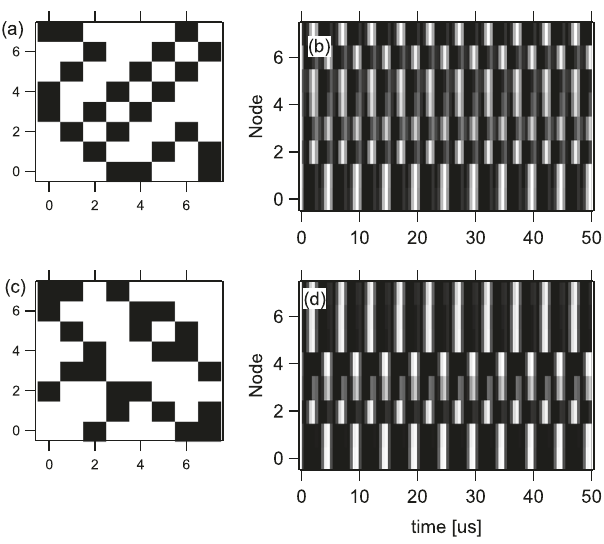
Fig. 6 Experimental evolution in two more frustrated random graphs. a A modi fi ed 3-regular graph, depicted in ( a ); b displays the steady-state circuit response. c Another 3-regular graph with steady-state response shown in ( d ). Both examples yield their respective ground states of energy E = −